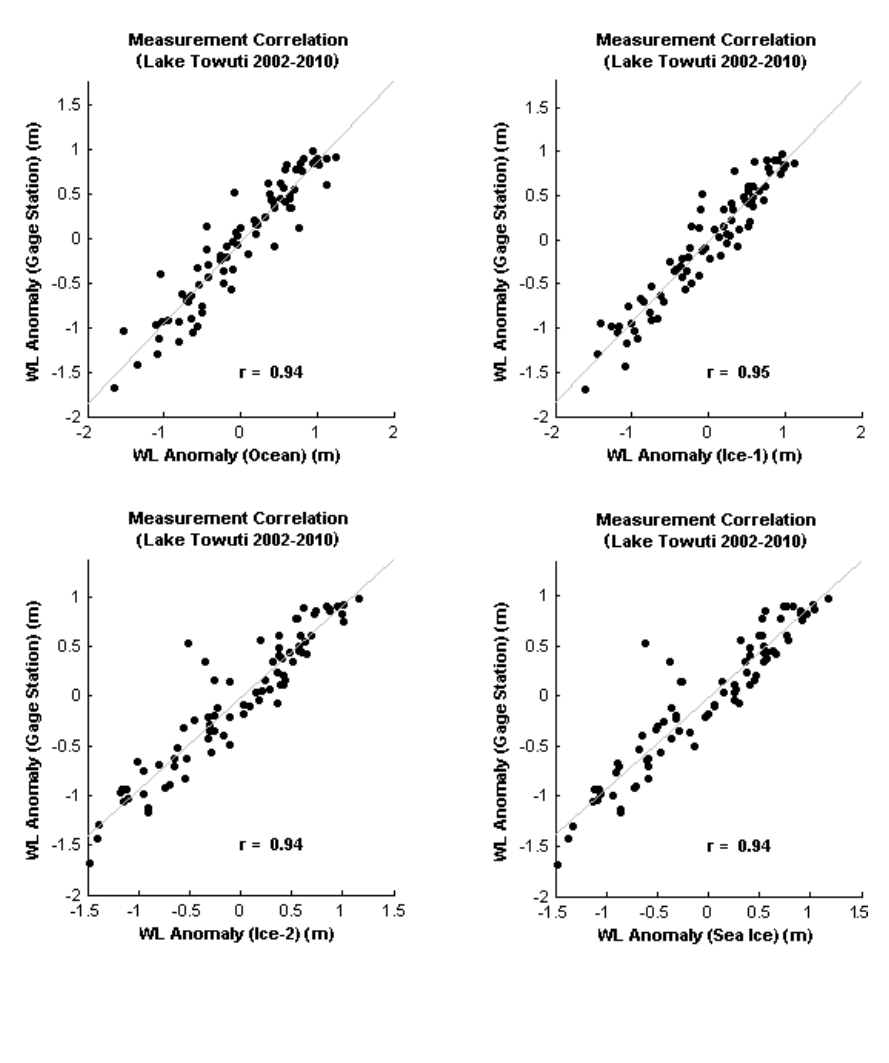
Figure 16. Correlation between the water level anomaly at Lake Towuti as measured by the Envisat RA-2 altimeter and processed with the